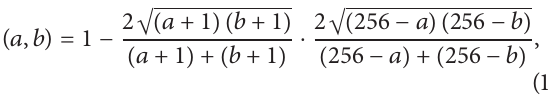
extract features from image sequence and used these features to identify humans. Liu et al. [19] represent one’s walking style by outermost contour.